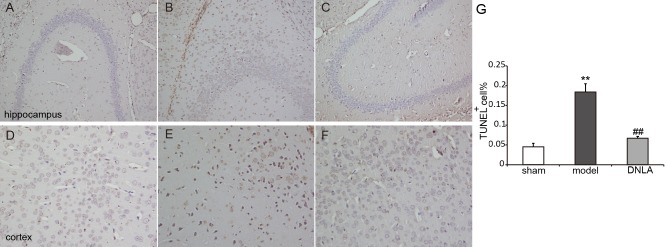
Images of TUNEL staining.Effects of DNLA on Aβ25-35-induced neuronal apoptosis in hippocampus and cortex. Sections of the hippocampus CA3 region and cortex were obtained and stained with TUNEL 184 staining (magnification, 200×). (A–C) showed the CA3 hippocampal cyto-architecture of mice in sham, model and DNLA groups, respectively; (D–F) showed the cortical cyto-architecture of mice in the sham group, model group and DNLA groups, respectively. The cells dyed brown are apoptotic cells. (G) The number of the apoptotic neurons in hippocampus and cortex (\documentclass[12pt]{minimal}
\usepackage{amsmath}
\usepackage{wasysym}
\usepackage{amsfonts}
\usepackage{amssymb}
\usepackage{amsbsy}
\usepackage{upgreek}
\usepackage{mathrsfs}
\setlength{\oddsidemargin}{-69pt}
\begin{document}
}{}$\bar {x}\pm ~SEM,n=3$\end{document}x ¯±SEM,n=3). **P < 0.01 vs. the sham group; ##P < 0.01 vs. the model group.